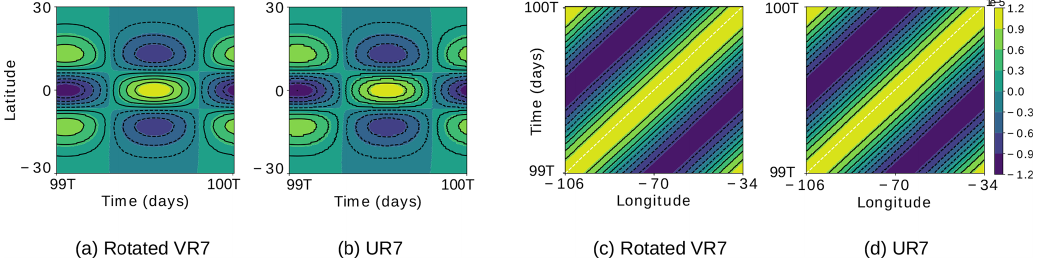
Figure 16. EIGW latitude–time Hovmöller diagrams for the simulated h (cid:48) in the rotated VR7 (a) and UR7 (b) grids, obtained fixing the longitude at λ = − 65 ◦ , and EIGW longitude–time Hovmöller diagrams for the simulated h (cid:48) in the rotated VR7 (c) and UR7 (d) grids obtained fixing the latitude at φ = 0 ◦ . T denotes the period of the EIGW (1.9d). The white dashed line has slope k EIGW time frequency and wavenumber, respectively.